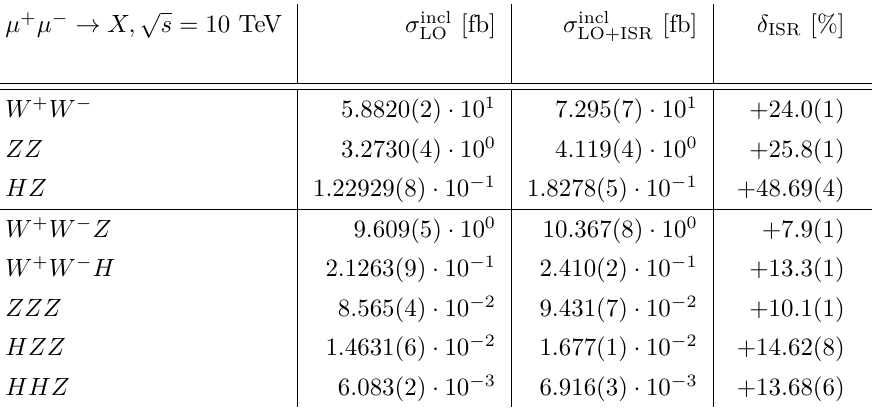
Table 5 . Total inclusive cross sections at LO with LL ISR photon resummation and relative correction δ ISR for two- and three-boson production at